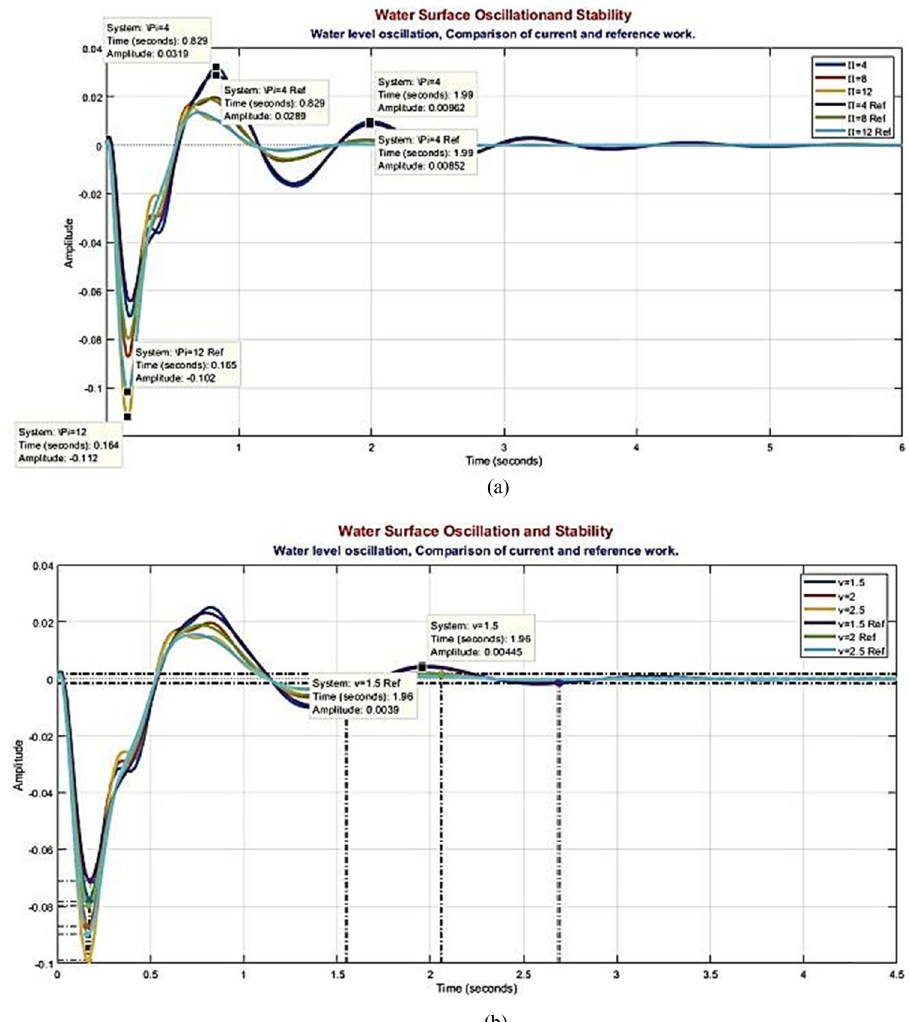
Figure 6: Comparison of results of di ff erent parameters e ff ect. ( a ) Di ff erent pressure e ff ect. ( b ) Di ff erent fl ow rate e ff